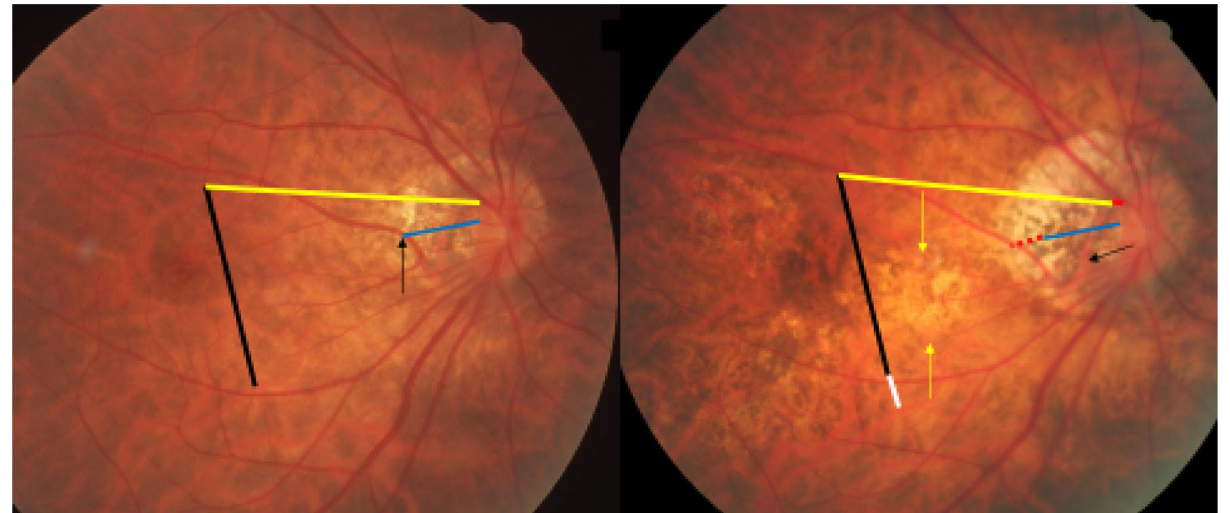
Figure 2. Fundus photographs of a highly myopic eye taken with an interval of 10 years (left image taken in 2001; right image taken in 2011). Note : Development and enlargement of a diffuse chorioretinal atrophy as category 2 of myopic macular degeneration (yellow arrows). Elongation of the distance from a choroidal vessel marking to the optic disc border, compared between baseline (yellow bar) and follow-up (equally long yellow bar plus red bar); the elongation of the distance between the disc border and the choroidal marker (red bar) is smaller than the enlargement of parapapillary gamma zone with large choroidal vessel tracings (black arrow) (2001: deep blue line; elongation in 2011: dotted red line); elongation of the distance between two choroidal vascular markings, compared between baseline (vertical black bar) and follow-up (equally long vertical black bar plus white bar), perpendicular to the longest axis of the diffuse chorioretinal atrophy region.